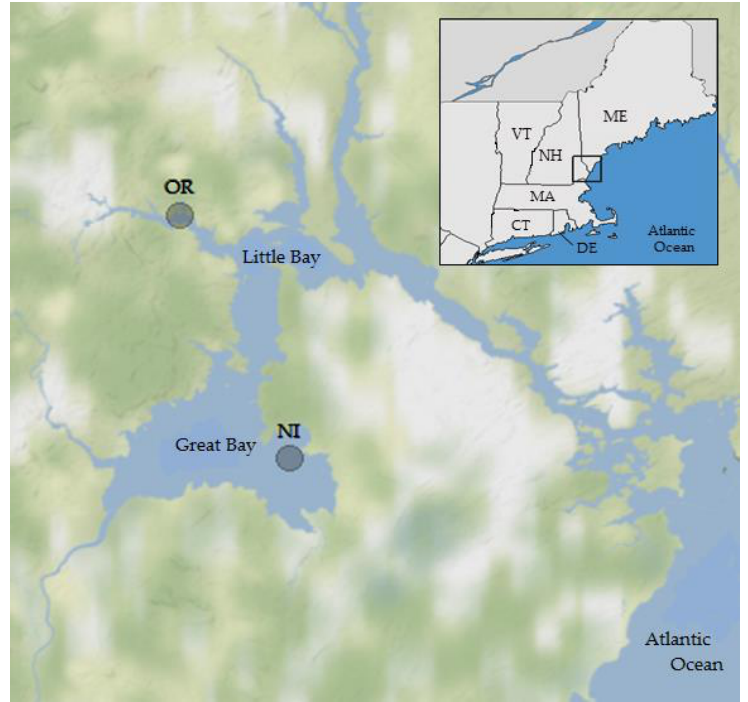
Figure 1. Study area and sites for oyster and water sampling in the Great Bay Estuary, New Hampshire, USA. OR = Oyster River; NI = Nannie Island.